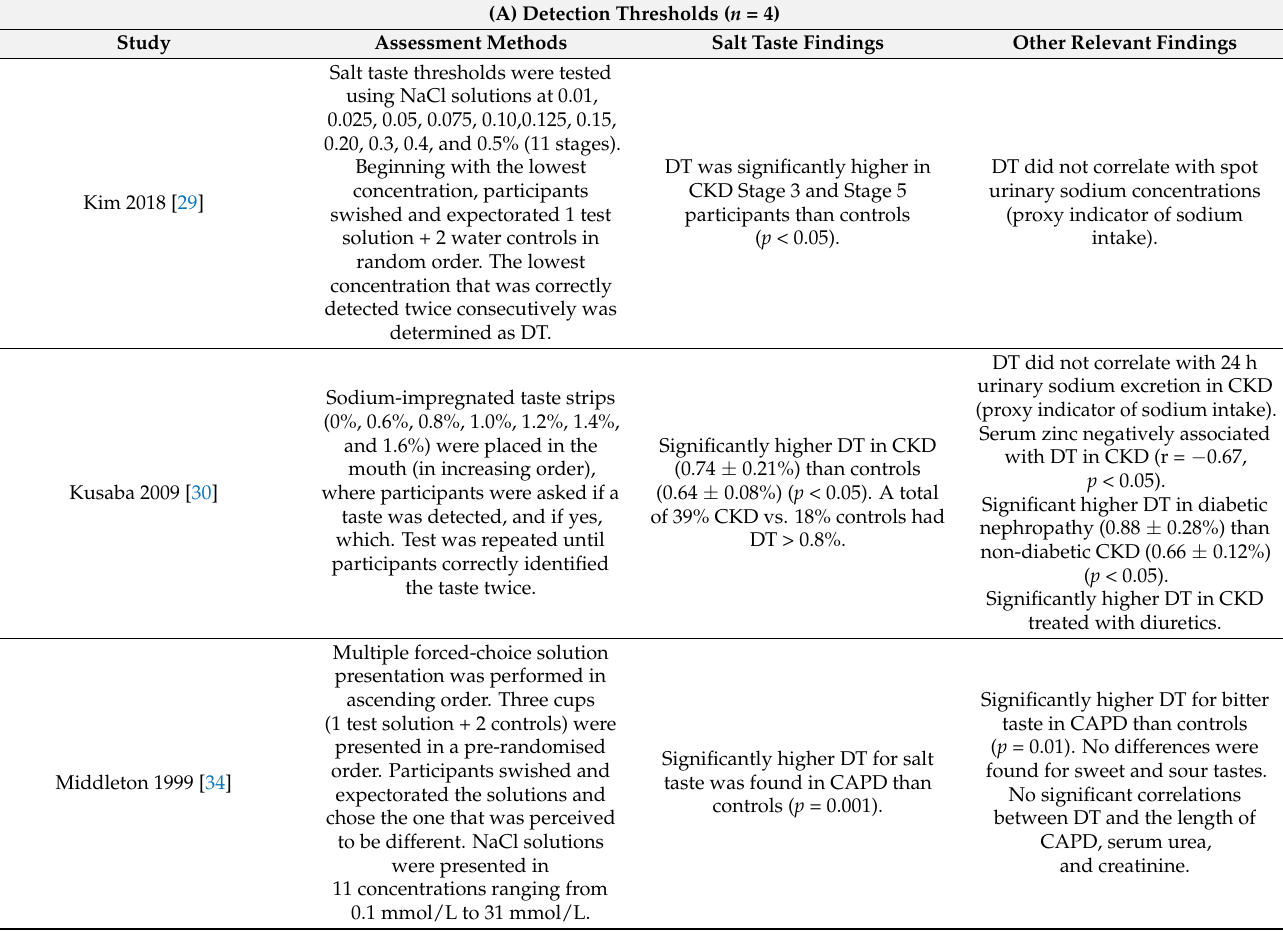
Table 3. Findings on the salt taste function and perception of individuals with CKD. (A) Detection Thresholds ( n =